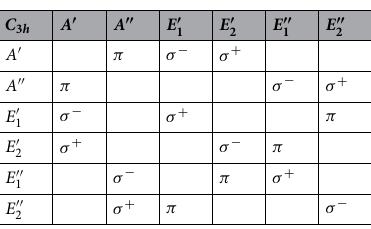
Table 4. Electric dipole selection rules in C 3 h symmetry. σ represents in plane transitions while π represents out of plane